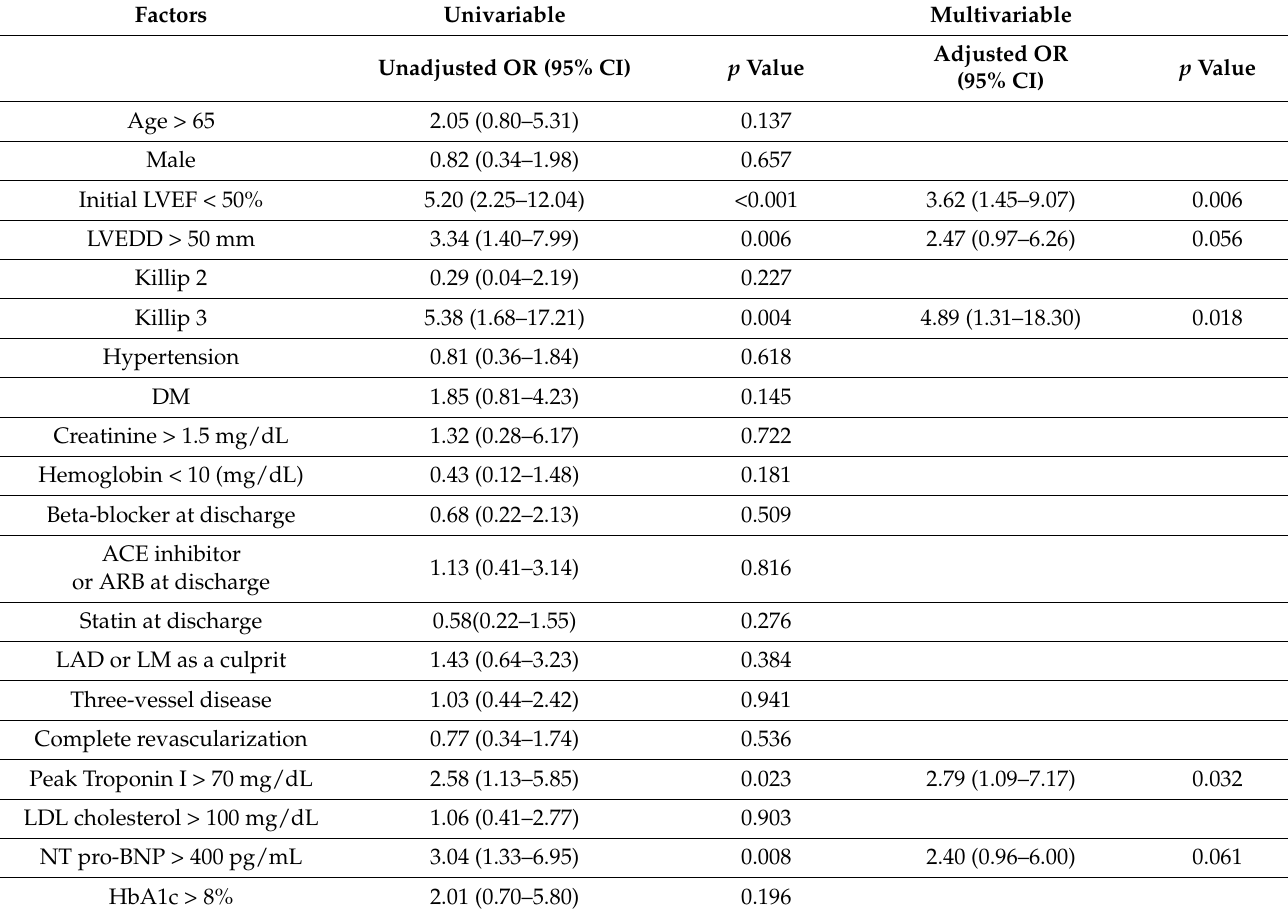
Table 3. Logistic regression: Factors related to LV